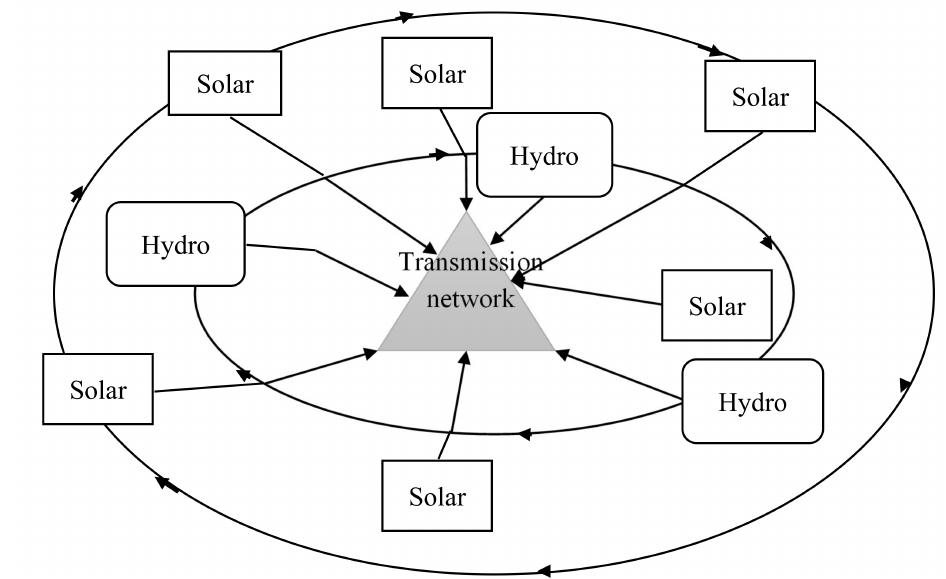
Figure 17. A layout of power generation in a smart connective